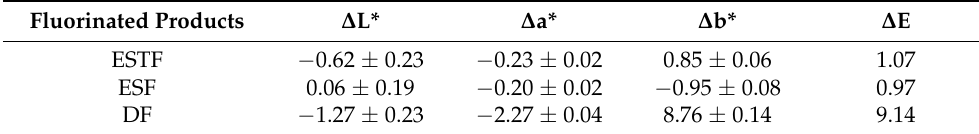
Table 8. Color changes after UV aging on glass slide after 254 h of